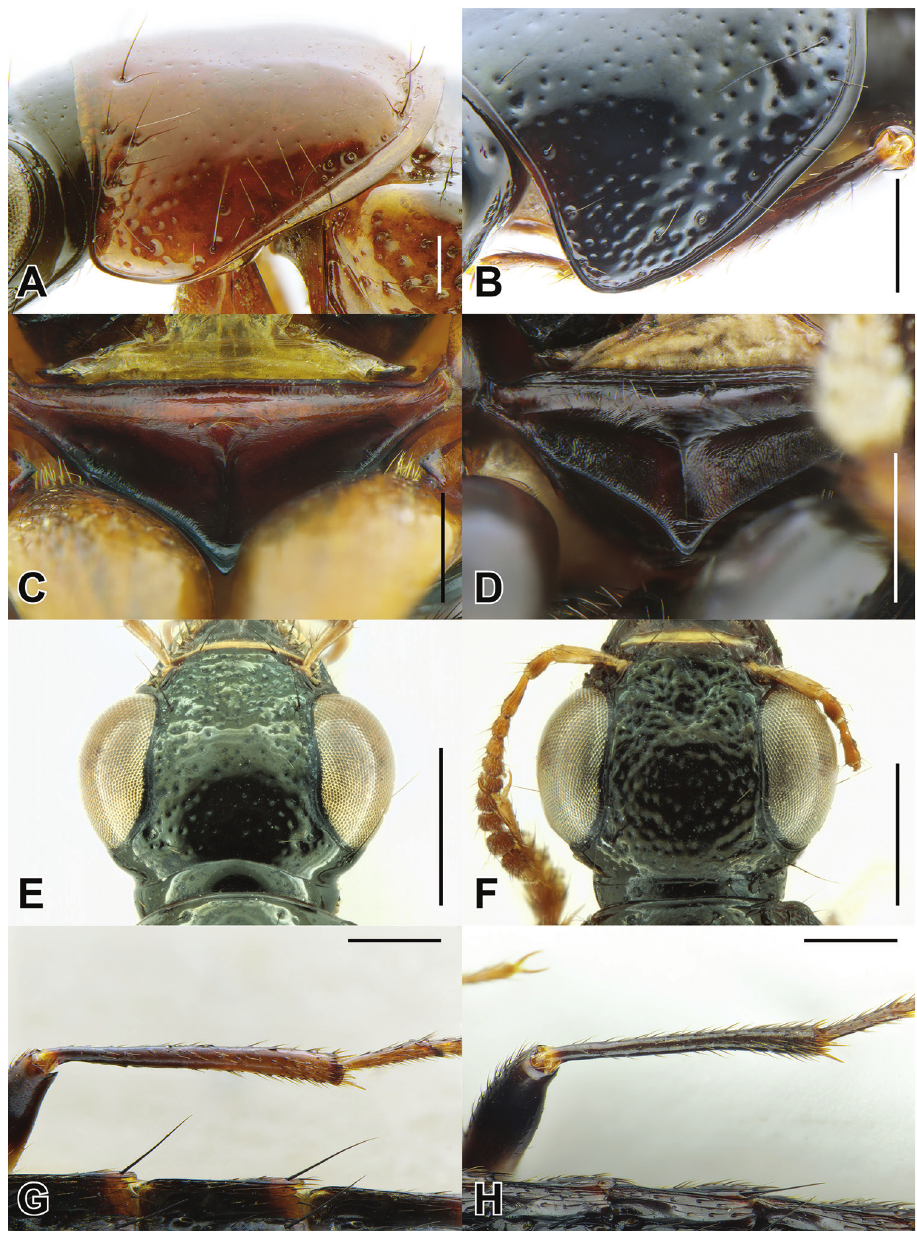
Figure 3. Pronotum, lateral: Bolitogyrus caesareus (Bernhauer) ( A ) and B. electus Smetana & Zheng ( B ). Prosternum: B. proximus (Cameron) ( C ) and B. electus ( D ). Dorsal head: B. electus ( E ) and B. nigerrimus Yuan et al. ( F ). Hind tibia: B. nigerrimus ( G ) and B. electus ( H ). Scale bars: 0.5